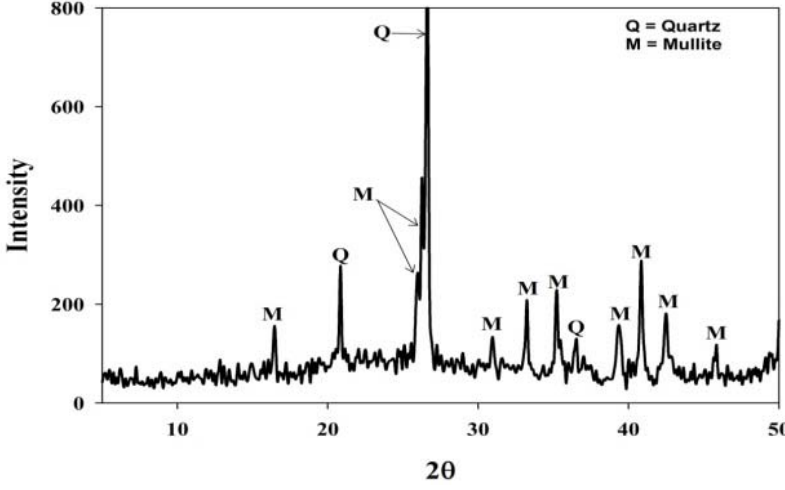
Figure 1. Powder X-ray diffraction patterns of coal fly ash from the Arnot power